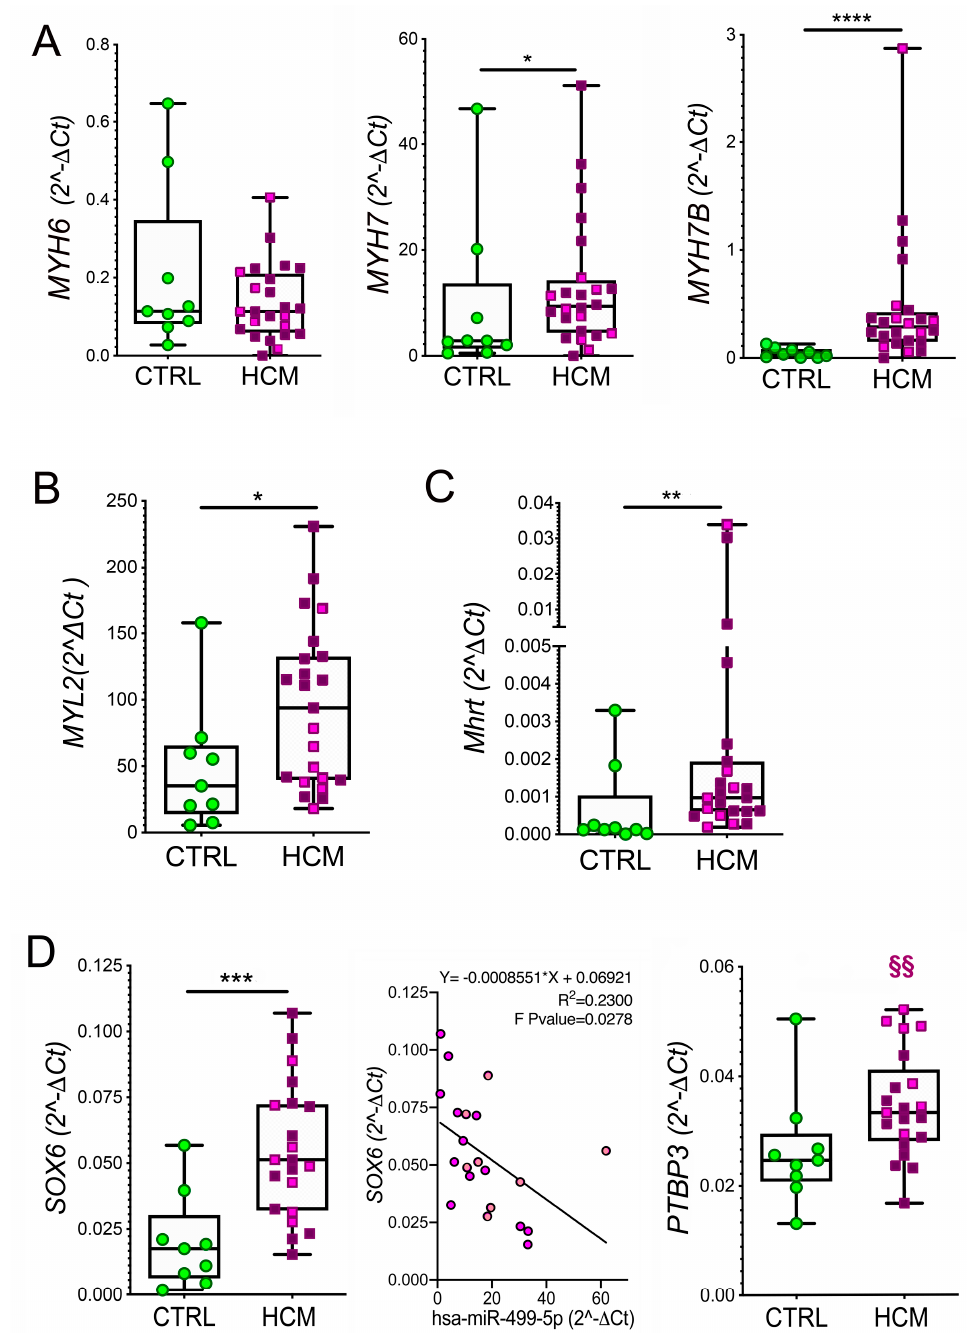
Figure 2. MyomiR network gene expression in myectomies: myosin genes, Mhrt and miR-499 targets. The expression levels of MYH6, MYH7 , and MYH7B mRNA ( A ), of MYLC2 mRNA ( B ) and of Mhrt ( C ) evaluated by RT-qPCR in the myocardium of HCM vs. CTRL are shown. Values are presented as boxes (min to max), and dots indicate single sample values. The expression levels of miR-499 -target genes coding for transcription factors, SOX6 (( D ) , left and middle panels ) and PTBP3 (( D ) , right panel ) by RT-qPCR are compared in the myocardium of HCM and CTRL. Values are presented as boxes (min to max), and dots indicate single sample values. The inverse relationship be- tween miR-499 and SOX6 is plotted (( D ) , middle , panel ). The HCM patients without HCM-associated mutations are presented in violet; those bearing mutations are in pink. Unpaired t -test is applied and significant differences are shown as * p < 0.05; ** p < 0.01 and *** p < 0.0005, **** p < 0.0001. Significance within HCM group between individuals with or without mutations is indicated as §§ p <